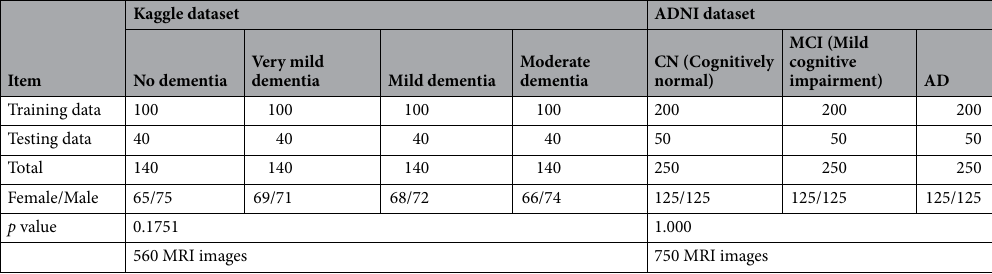
Table 1. The demographic characteristics for Alzheimer’s disease